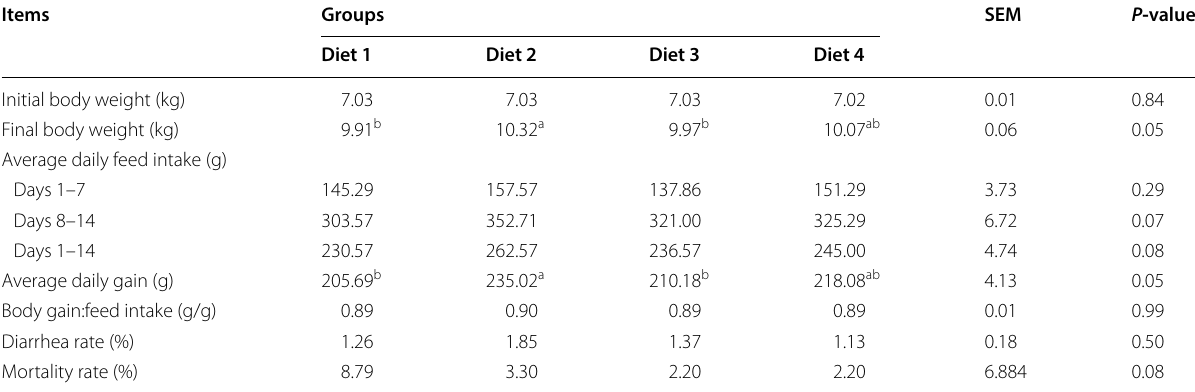
Diet 1: containing 75 mg/kg aureomycin; Diet 2: containing 50 mg/kg aureomycin; Diet 3: containing 50 mg/kg aureomycin and 9 containing 50 mg/kg aureomycin and